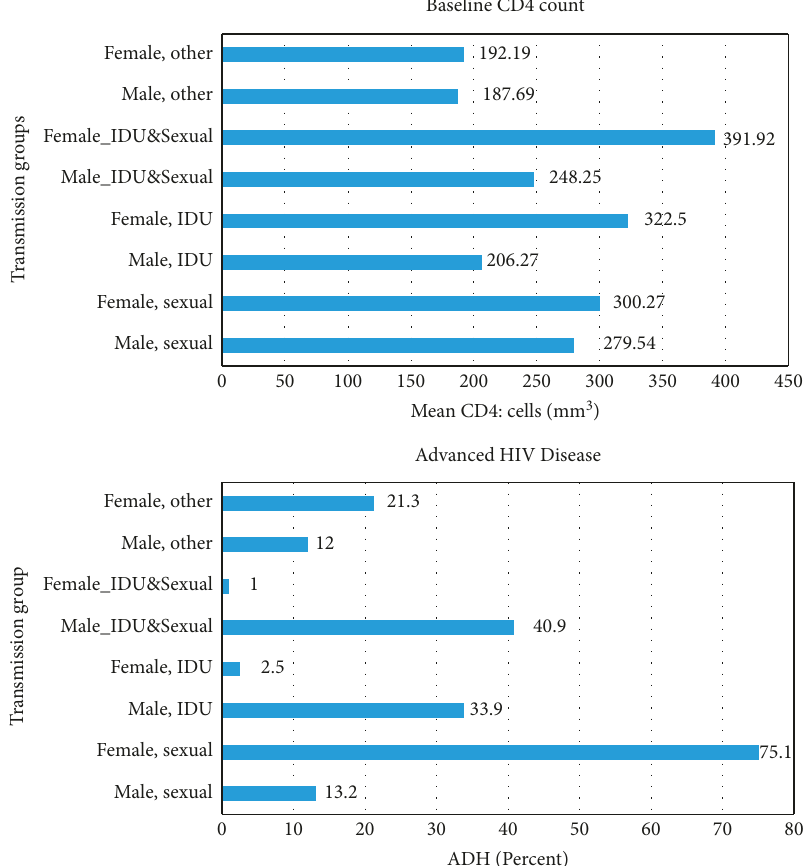
Figure 1: Percentages of advanced HIV disease and mean baseline CD4 from1997 to 2021 by transmission groups (sexual route, IDU, and others (mother to child, blood transition, and unknown)) and